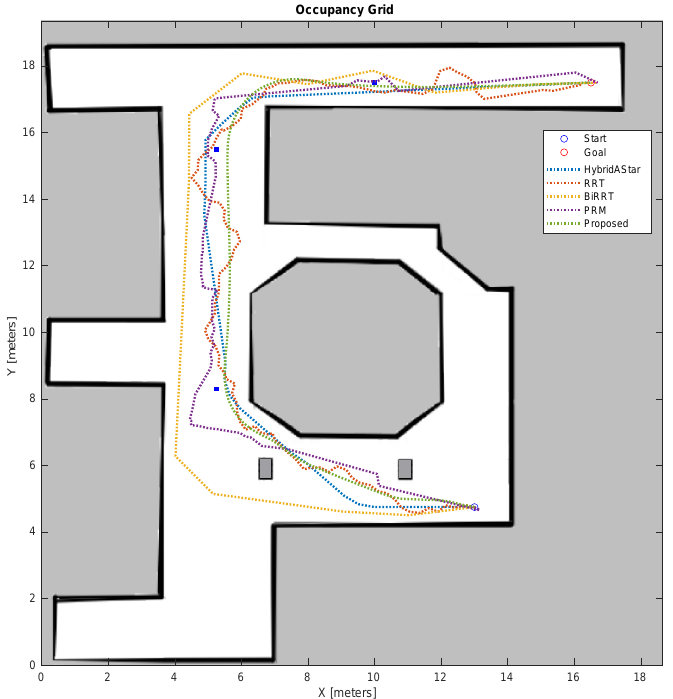
Figure 9. Paths obtained during the navigation on an obstacles-free environment.